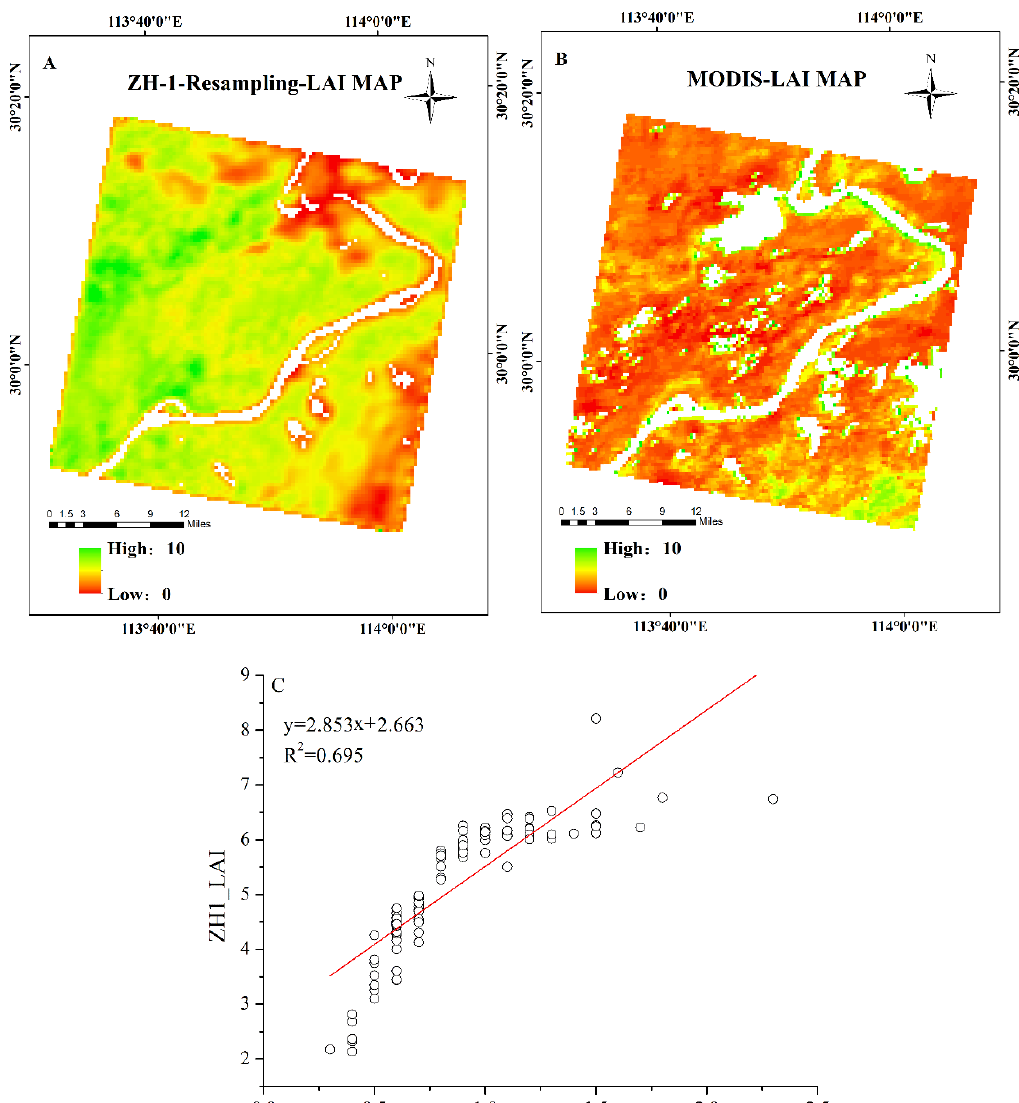
Figure 7. ( A ): LAI map of the study area using the optimal band combination of resampled ZH-1 hyperspectral satellite; ( B ): MODIS LAI map of the study area; and ( C ): correlation between the ZH-1 LAI estimation and the MODIS LAI for randomly selected pixels from the ZH-1 LAI map and the MODIS-LAI product, respectively.